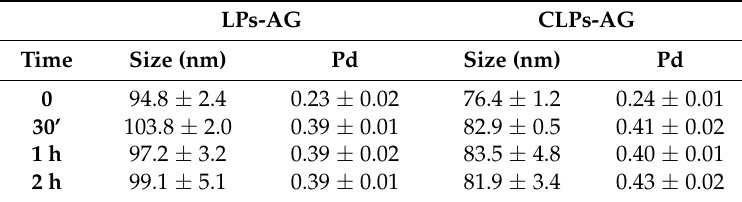
Table 3. Physical stability of LPs-AG and CLPs-AG in presence of human serum